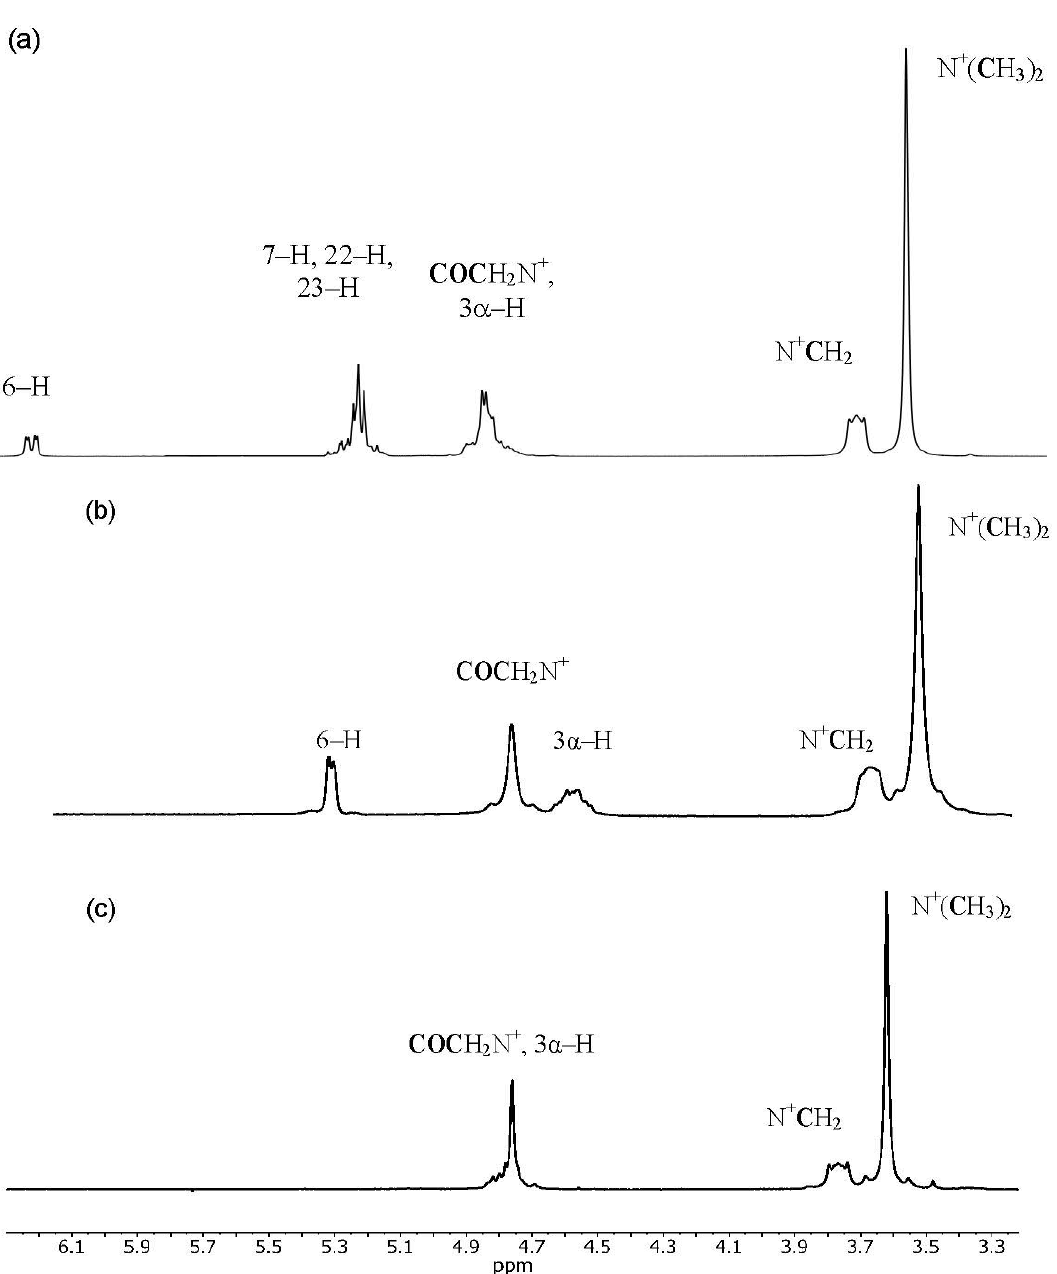
Figure 3. 1 H-NMR spectra in the 6.2–3.3 ppm region showing the most characteristic signals of conjugates 9 ( a ), 13 ( b ) and 17 ( c